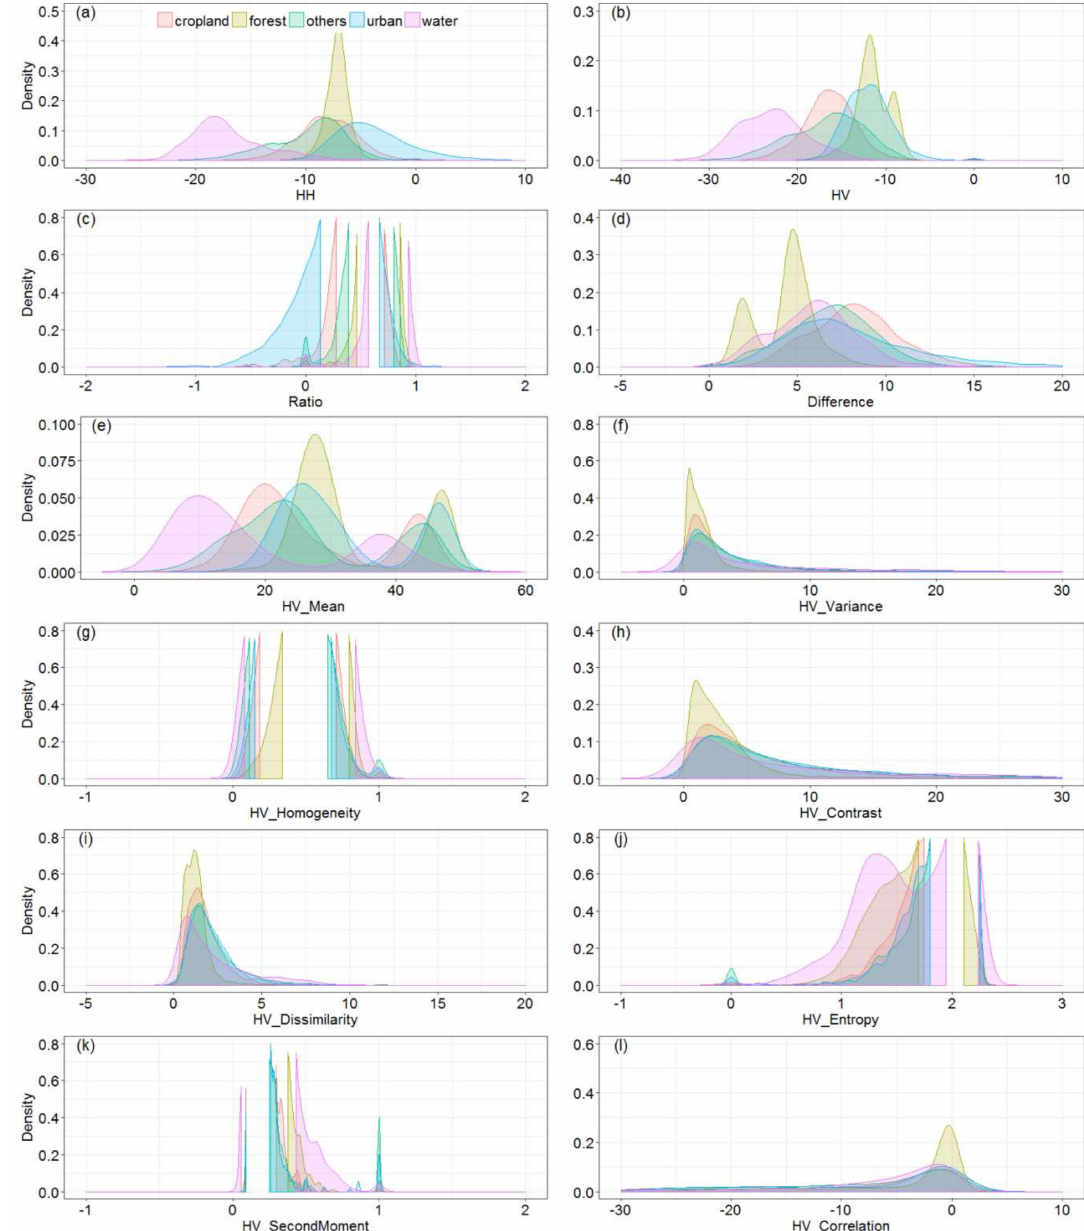
Figure 4. Kernel density distribution plots of land cover types (cropland, water, forest, urban, and other types) from PALSAR-based variables of HH ( a ), HV ( b ), Ratio ( c ), Difference ( d ), and HV textural measures (e.g., mean ( e ), variance ( f) , homogeneity ( g ), contrast ( h ), dissimilarity ( i ), entropy ( j